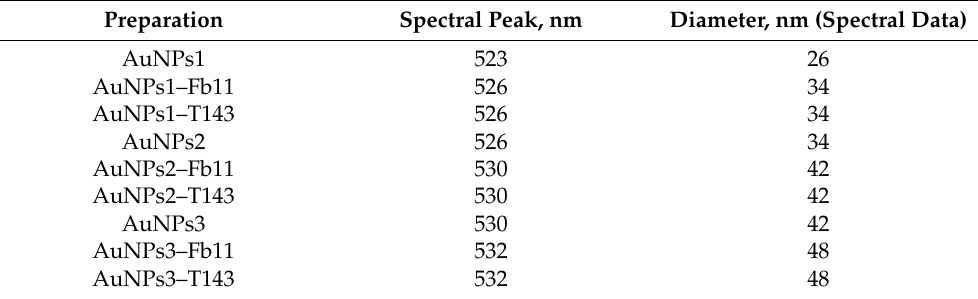
Table 3. Spectrophotometric characterization of AuNPs–MAbs